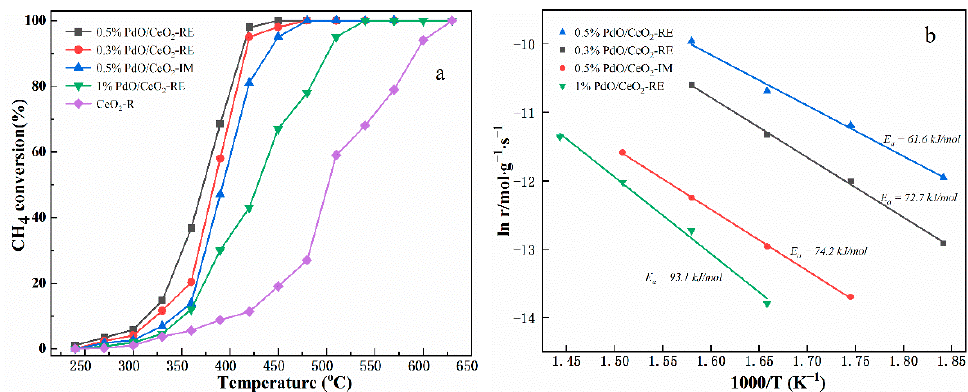
Figure 7. CH 4 conversion of CeO 2 -R and Pd/CeO 2 catalysts ( a ) and ln r as a function of 1/ T on Pd/CeO 2 catalyst ( b ).